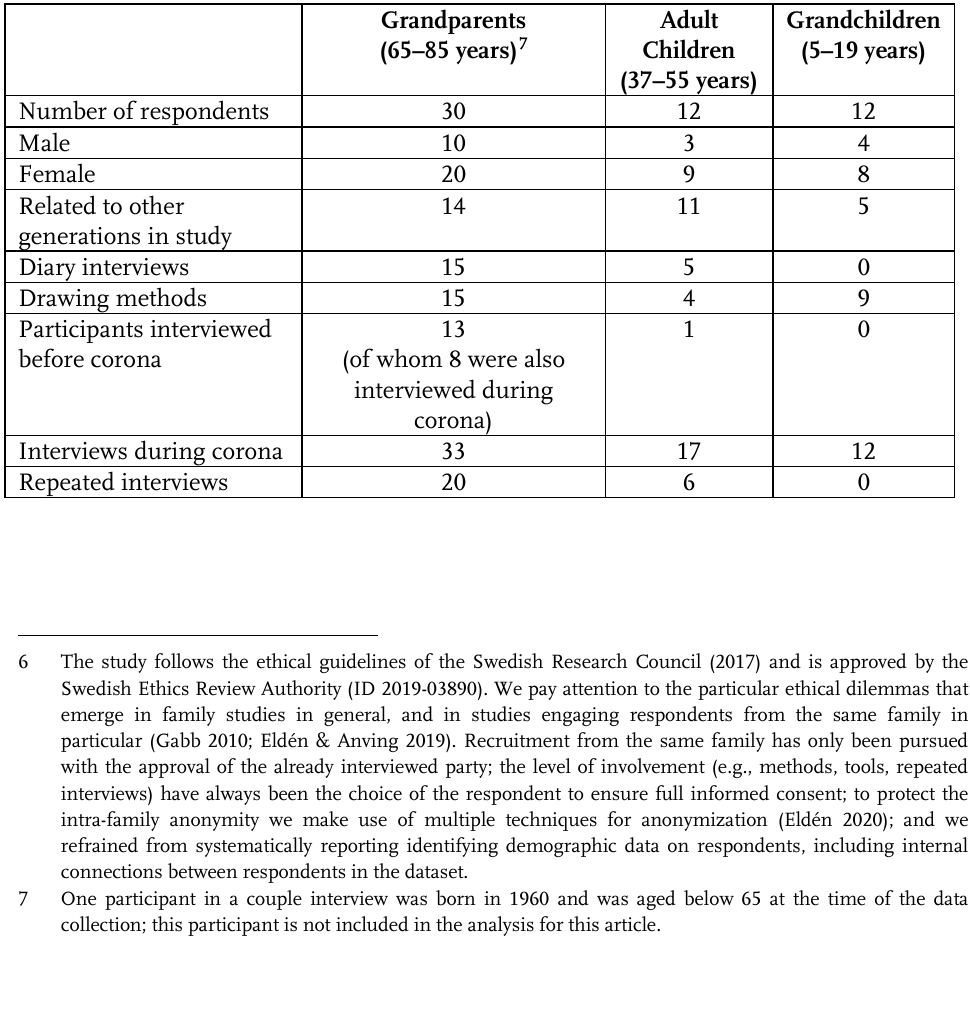
Table 1 : Profile of participants and interviews